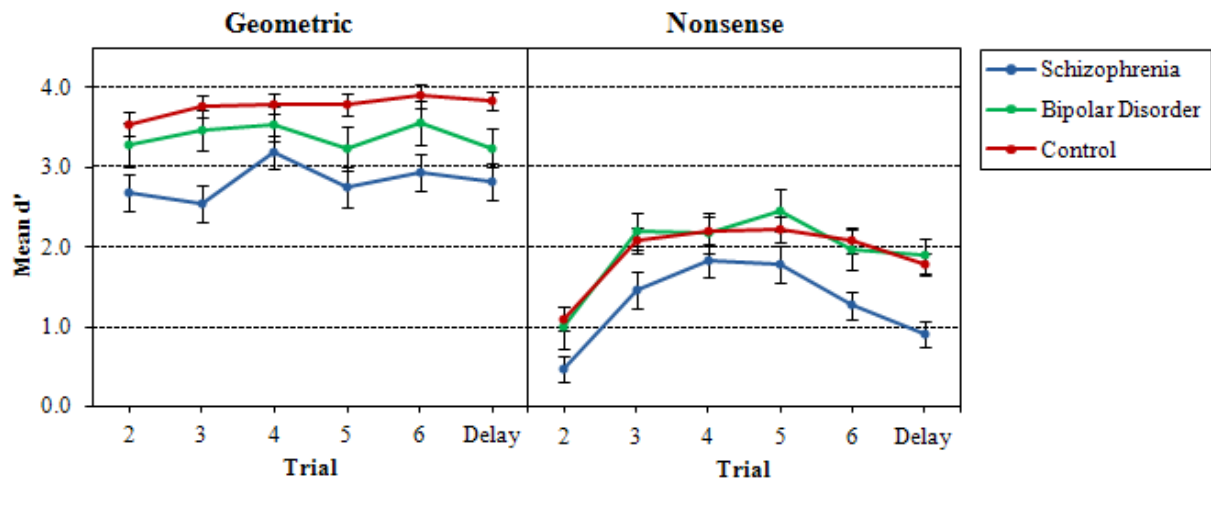
Figure 3. Mean d' for geometric and nonsense designs across Trials 2–6 and delayed trials (7–8) for probands with schizophrenia and bipolar disorder and nonpsychiatric